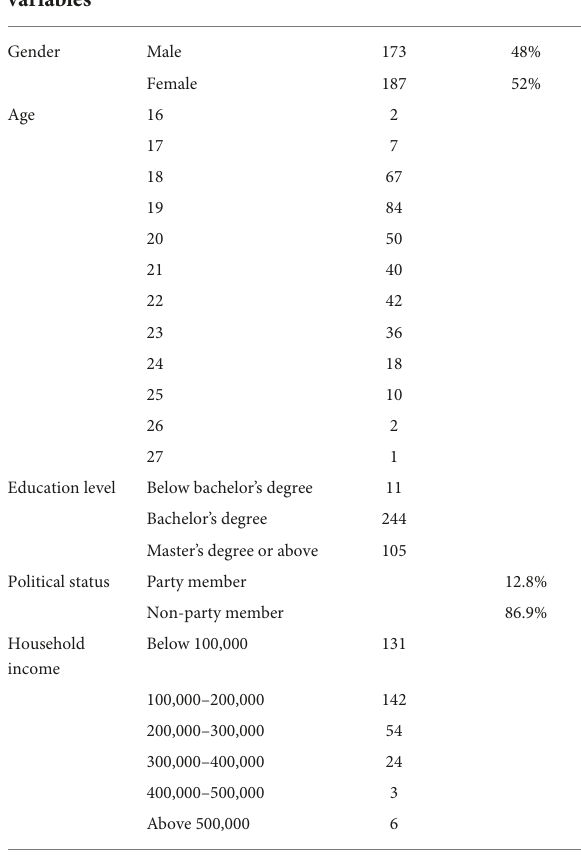
TABLE 6 Statistics of demographic